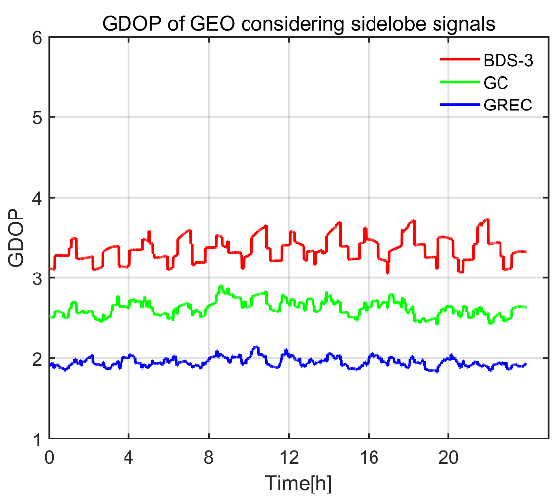
Figure 10. GDOP of GEO spacecraft.